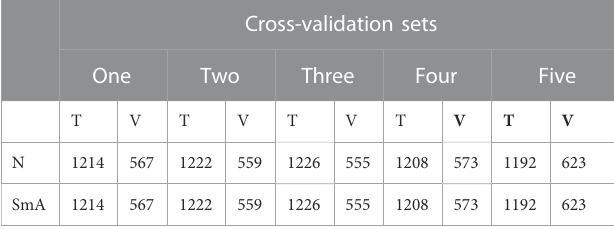
TABLE 1 Number of training (T) and validation (V) images in the N-SmA datasets. Cross-validation sets